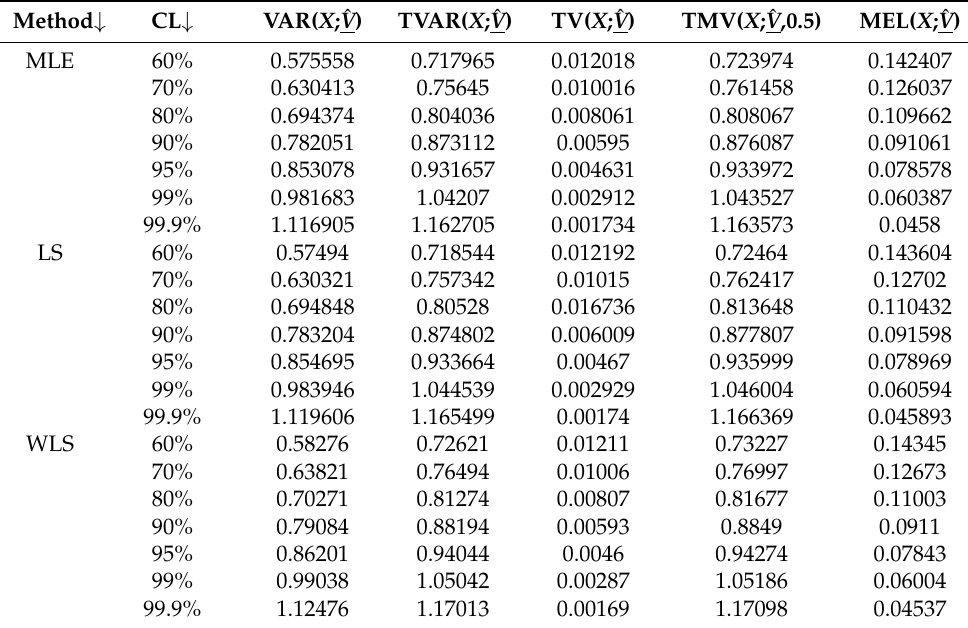
Table A1. The KRIs for the GRC under artificial data where n =